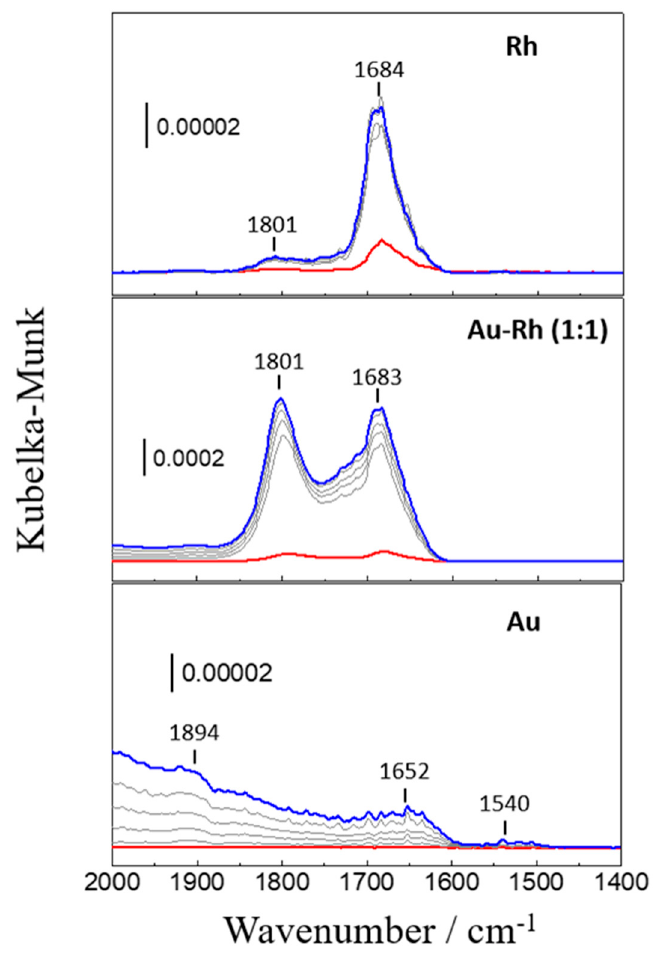
Figure 6. In situ DRIFTS spectra recorded during NO adsorption on Rh/Al 2 O 3 , AuRh(1:1)/Al 2 O 3 , and Au/Al 2 O 3 catalysts at 30 °C for 5 min (from the red line to the blue line at an interval of 1 min). Gas mixture: 2000 ppm NO and He balance; total flow rate: 100 mL/min.